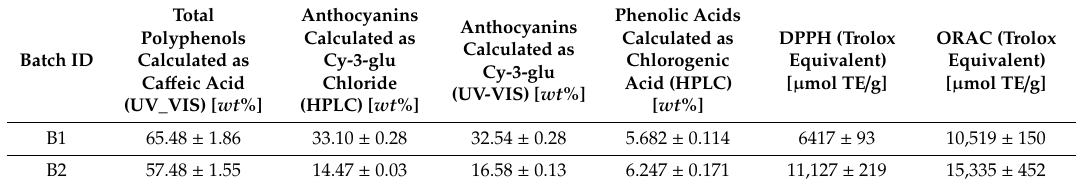
Table 1. Antioxidant activity and the content of marked components of Aronia melanocarpa extracts.